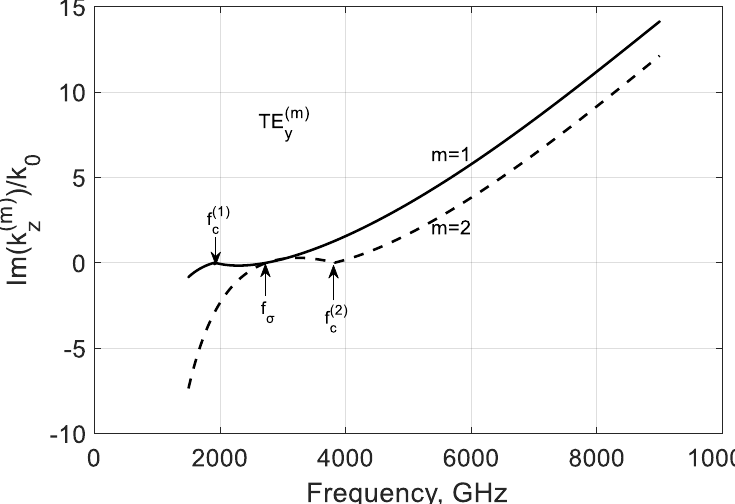
(cid:18) (cid:19)   ( m ) ( m ) Im m k k of the first two k of the first two TE 0 z y z / k 0  k of the first two